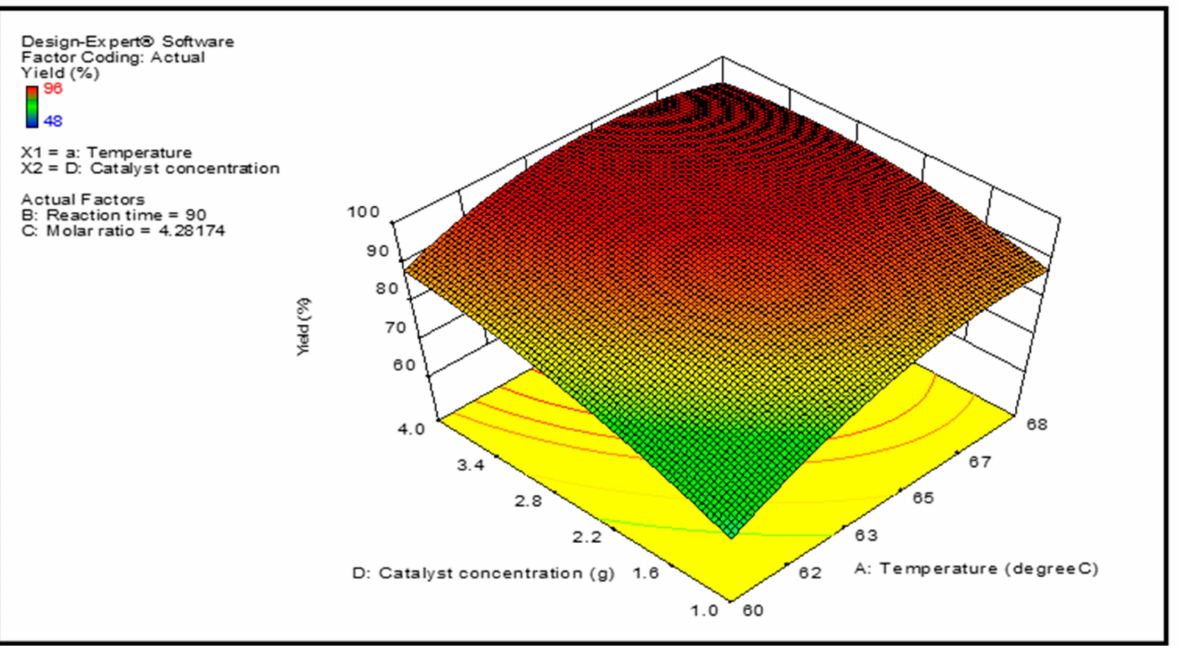
Figure 9. Projected biodiesel production against temperature and catalyst concentration on a response surface 3D